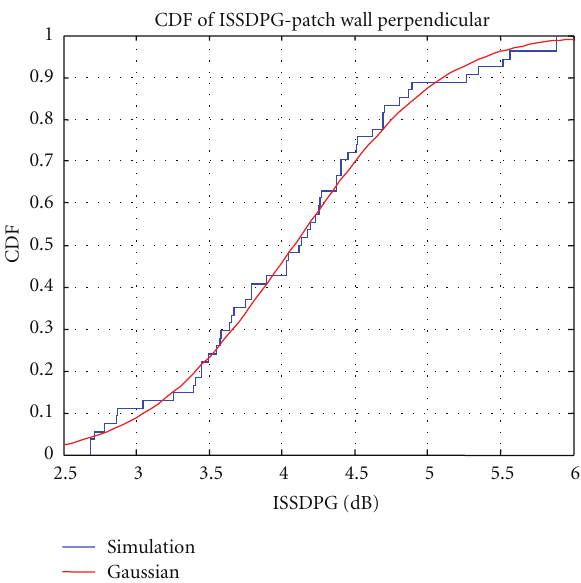
Figure 14: Dipole array locations and